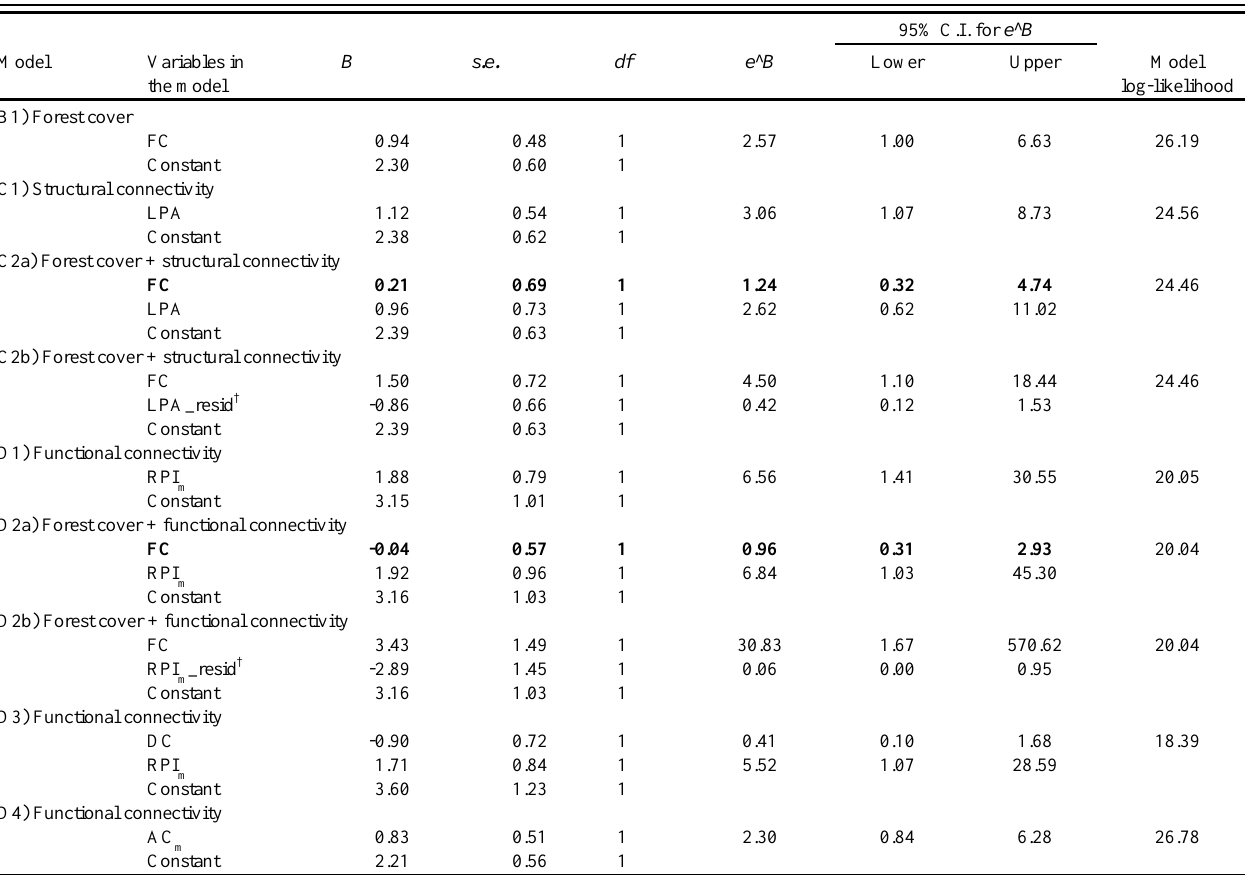
Table 4 . Logistic regression models for S. citrina nest occurrence in 2005 ( n = 41) using standardized forest cover, and structural OR functional connectivity measures. The odds ratio in logistic regression (e^B) is the exponent of a parameter estimate and this provides an indication of effect size when variables are standardized. Generally odds ratios can be interpreted as the increase (or decrease) in the likelihood of (nest) occurrence with a one unit change in the predictor variable. Variable codes and transformations are described in Table